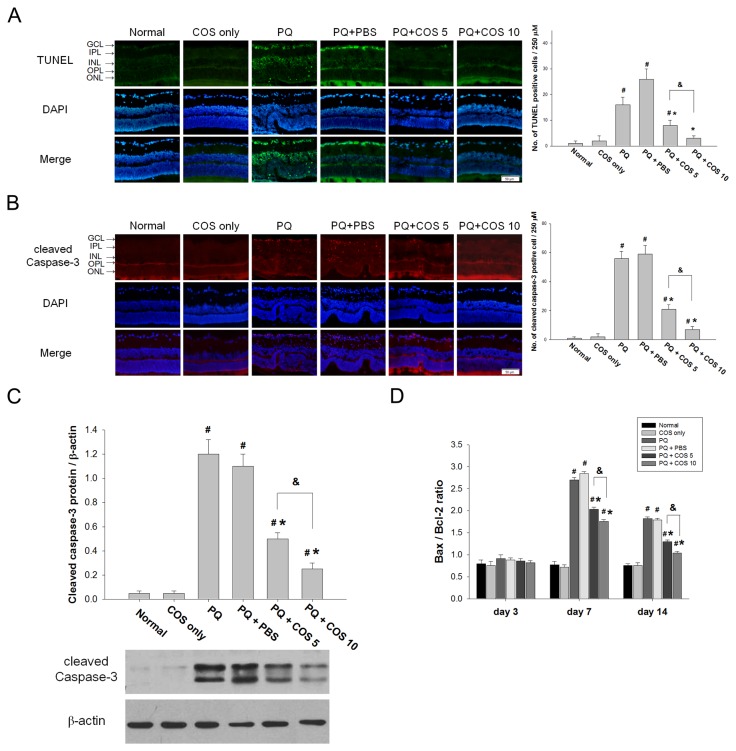
Effects of COS on retinal cell apoptosis.(A). Retinal apoptosis was evaluated by using TUNEL stain. In PQ only and PBS-treated group, TUNEL-positive cells were detected in GCL of the retina, whereas only sparse TUNEL-positive cells in GCL of retina were noted in COS-treated group at day 14. (B). Retinal sections and staining with anti-cleaved caspase-3 antibody. There are significantly few cleaved caspase-3-positive cells in GCL of retina in COS-treated group than in the PQ only and PBS-treated group at day 14. (C).Effects of COS on the expression of cleaved caspase-3 protein in retina. The protein level of cleaved caspase-3 in retina was evaluated by western blot analysis. The cleaved caspase-3 protein was significantly lower in the low-dose and high-dose COS treatment group than in the PQ only or PBS-treated group at day 14. (D). Effects of COS on Bax/Bcl-2 ratio. The amounts of Bax and Bcl-2 in retina were measured by ELISA and the ratio was calculated. Treatment with low-dose or high-dose of COS caused significantly decrease in Bax/Bcl-2 ratio at day 7 and 14. (*P < 0.05 compared with PQ only or PBS-treated group; # P < 0.05 compared with normal; & P< 0.05 by ANOVA test with post hoc Bonferroni test; N=3 for each group in each time point).